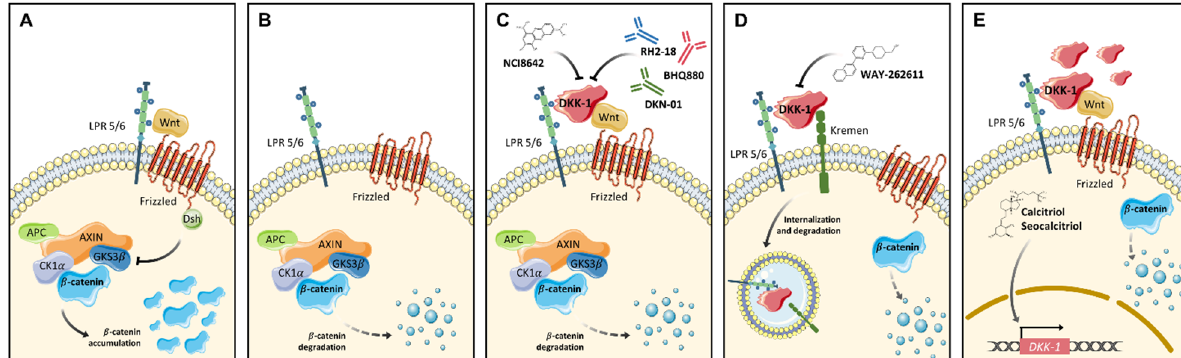
Figure 2. Strategies to target DKK proteins. ( A ) When Wnt signaling is active, Wnt ligands bind to Fz receptor and the LRP5/6 co-receptor, thereby producing the inhibition of the degradation complex (APC-Axin-CK1 α -GKS3 β ) and consequent β -catenin accumulation and stabilization. ( B ) If Wnt ligands do not bind, the destruction complex is active and the degradation of β -catenin is produced. ( C ) DKK-1 blocks Wnt and LPR5/6 interaction by activating the degradation complex and further inhibition of the signaling by β -catenin degradation. NCI8642, RH2-18, BHQ880 and DKN-01 are able to block this specific DKK-1 activity. ( D ) The interaction of DKK-1 with LPR5/6 and Kremen proteins produces DKK-1 internalization together with the LPR5/6 receptor. The WAY-262611 compound can inhibit Kremen-LRP5/6-Dkk-1 complex formation. ( E ) Activators of DKK-1 such as vitamin D analogs induce the transcription of DKK-1 gene thereby increasing DKK-1 protein levels and the subsequent Wnt signaling inhibition.